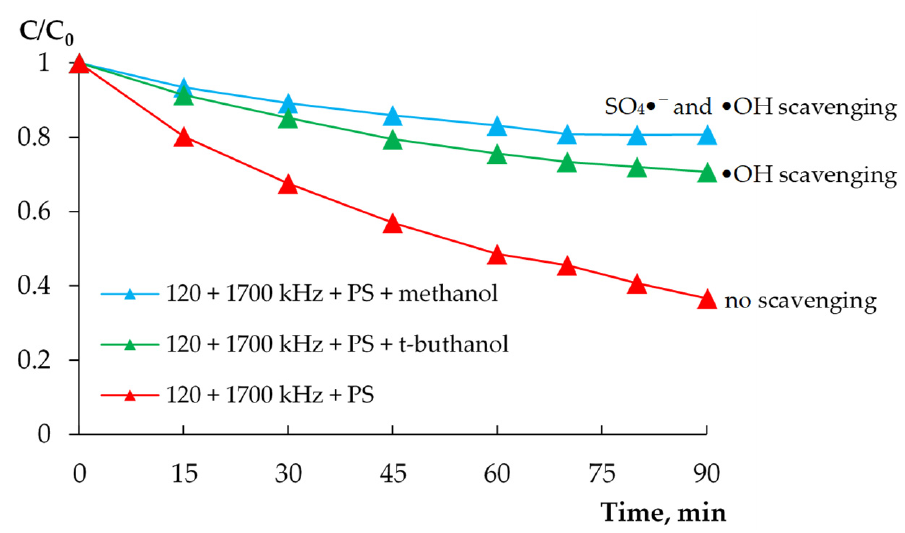
Figure 5. p CBA degradation by dual-frequency ultrasound in the presence of alcohols. [ p CBA] 0 = 20 µ M, [PS] 0 = 200 mg/L (0.74 mM), [alcohol] 0 = 74 mM.